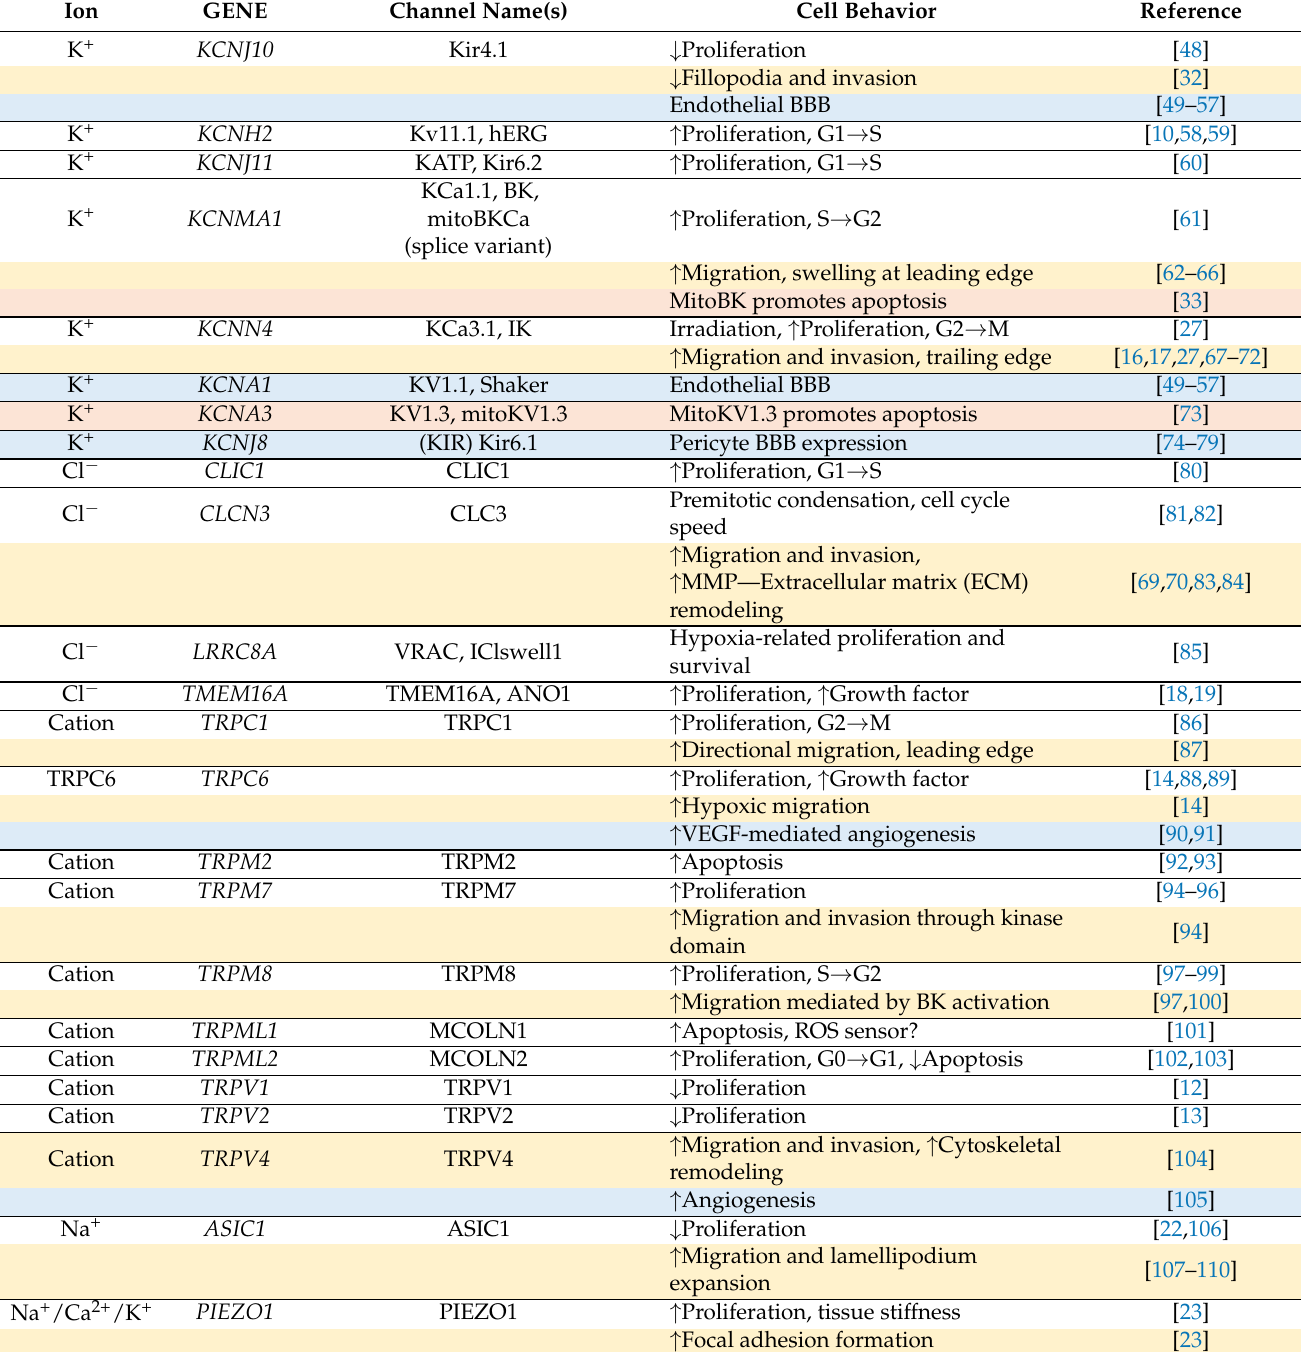
Table 2. Ion channel behaviors. This table summarizes cell behaviors of various ion channels: proliferation (clear), metastasis and invasion (yellow), metabolism (red), angiogenesis and tumor microenvironment (TME) (blue), apoptosis, or seizure-related behavior (green). BBB, blood–brain barrier. “ ↑ ” indicates increased, “ ↓ ” represents decreased, “ → ” indicates, for example in G1 → S, cell cycle progression from G1 to S phase. GABR , Gamma-aminobutyric acid type A receptor subunits